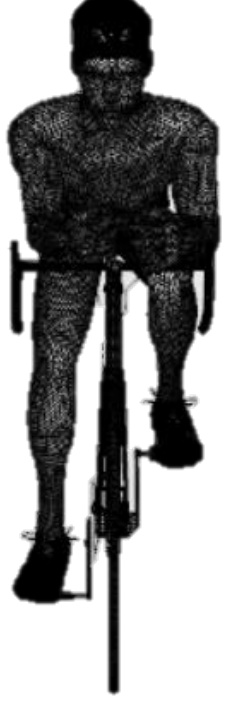
Figure 1. The meshed geometry in the aero position.